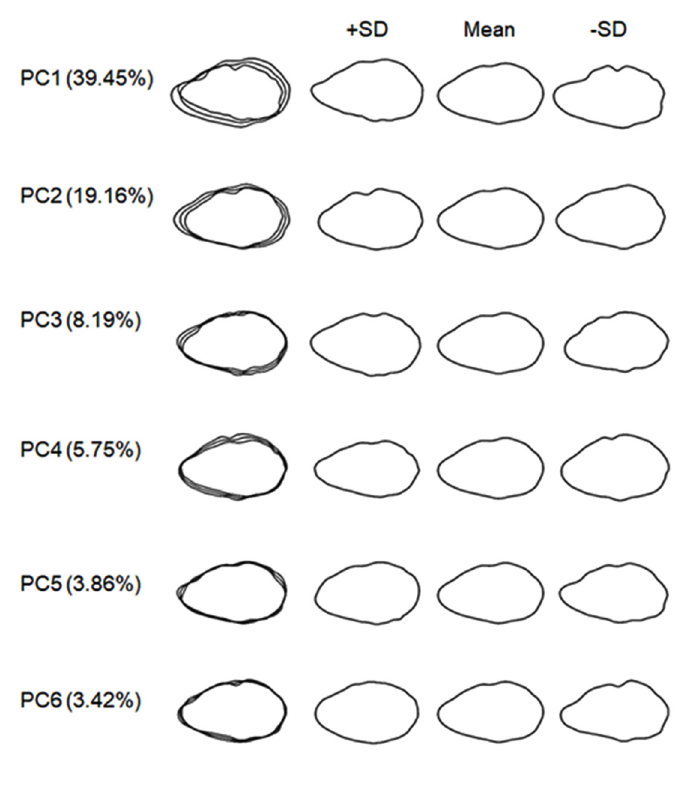
FIGURE 5 | Variation in shape (mean ± standard deviation – SD) in sagittae of C. temensis populations explained by the first five principal components